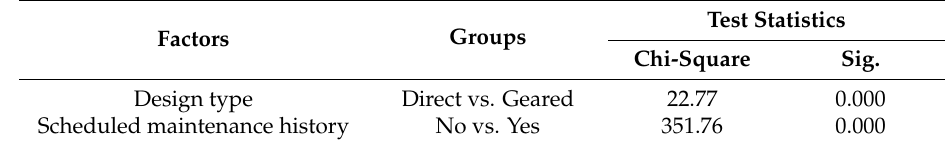
Figure 4. Kaplan–Meier survival functions of electrical subsystems based on the operational, climatic and geographic factors. ( a ) Design type ( b ) Climatic regions ( c ) Turbine age ( d ) Scheduled maintenance history ( e ) Distance to coast ( f ) Elevational location ( g ) NOPF ( h ) MAWS. Table 7. Log-rank test results for the comparison of the factors impacting on electrical subsystem failures.